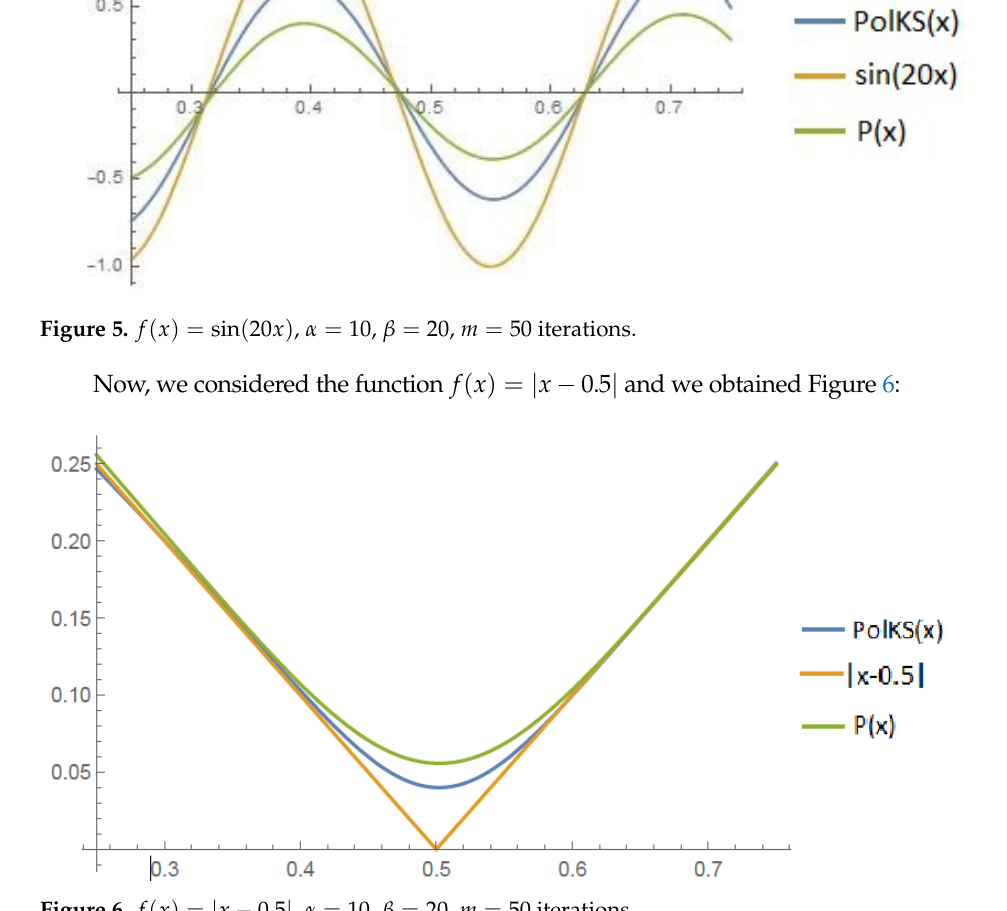
Figure 6. f ( x ) = | x − 0.5 | , α = 10, β = 20, m = 50